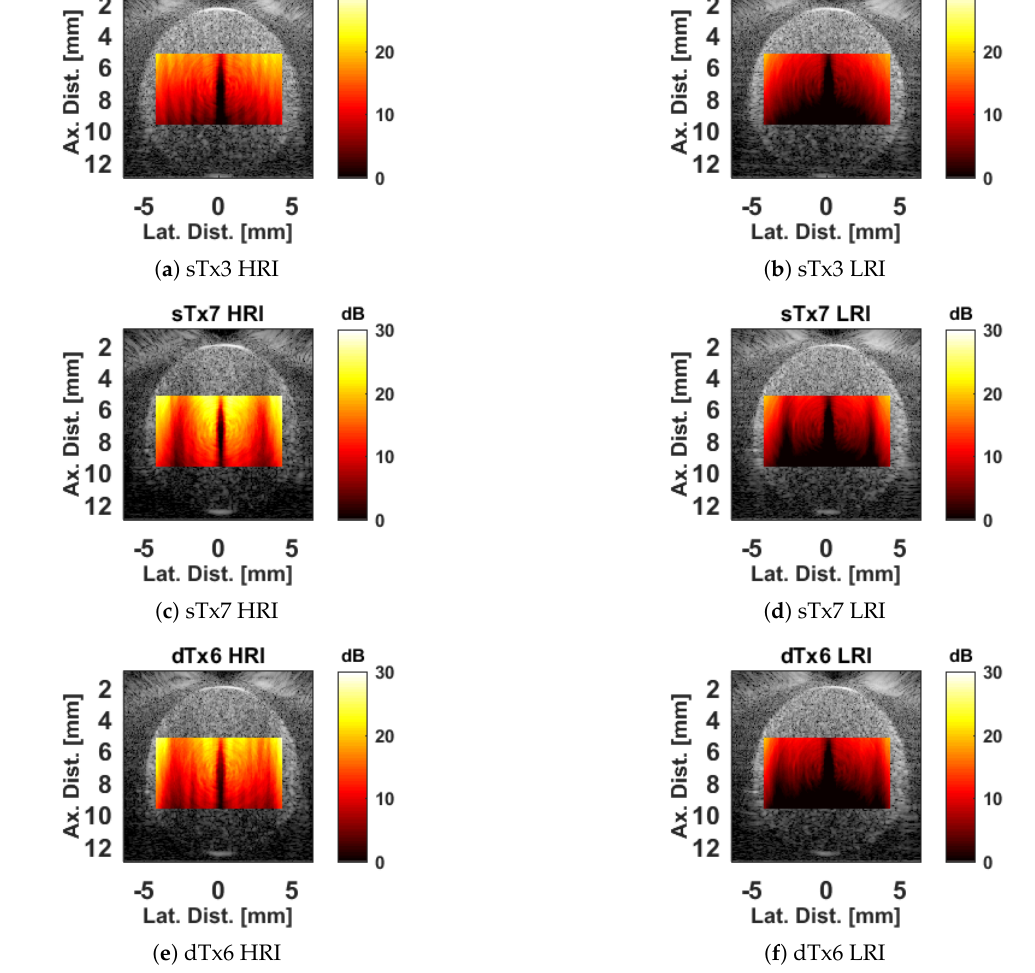
Figure A5. Power Doppler images generated from the experimental data. The HRI images are shown on the left, and the LRI images are shown on the right, with each row corresponding to a different dataset. The pairwise results are omitted, since they lacked a descriptive metric to characterize the power in such a way that would account for the pairwise estimation scheme. One should note the presence of spatial notches in the images. These notches correspond to velocities in the clutter filter stop band. The notches appear to spread out with depth, which is believed to be due the cumulative effect of attenuation. All images are rendered with the same color scale to facilitate easy comparisons. The lateral banding the sTx3 and dTx6 HRI processing schemes is believed to be due to an artifact in the broadside transmission that is specific to the Verasonics Vantage system. This artifact is likely due to the simultaneous excitation of all the elements. The effect is suppressed in the sTx7 dataset due to the additional steered excitations which do not exhibit this